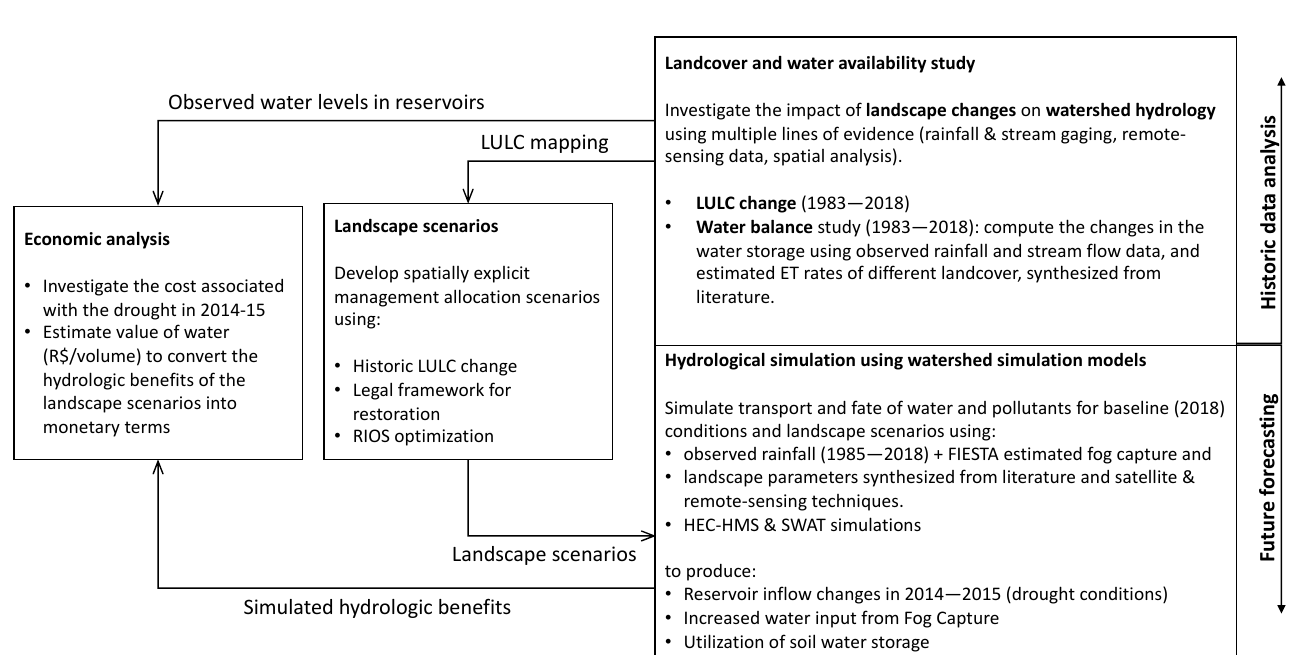
Figure 8. Synthesis of multiple lines of historical environmental data and landscape simulation models and economic analysis.